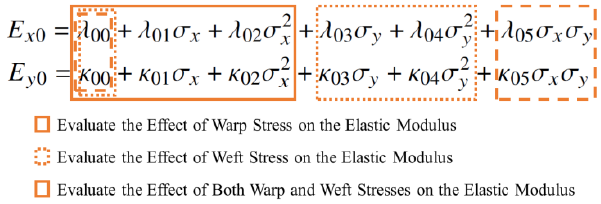
Figure 1. Significance of each monomial term.